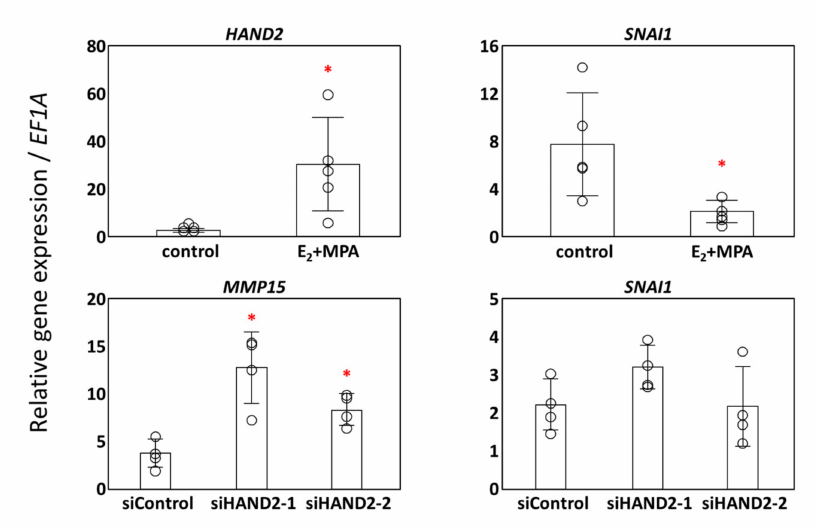
Figure 3. Effect of siRNA-mediated HAND2 silencing on the expression of MMP15 or SNAI1 in human endometrial stromal cells. Human endometrial stromal cells (ESCs) were treated with E 2 (10 − 8 mol/L) + MPA (10 − 7 mol/L) or without hormonal treatment (control) for 12 days. HAND2 and SNAI1 were analyzed by quantitative RT-PCR ( n = 5, upper panels). ESCs were transfected with human HAND2 siRNA (HAND2-1 and HAND2-2) or a non-silencing RNA on day 0 and then cultured for 5 days without hormonal treatment (lower panels). MMP15 and SNAI1 were quantified using quantitative RT-PCR and corrected for EF1A (lower panels). The bars show the mean of relative gene expression ± SD of independent experiments using cells derived from different patients ( n = 4). Each dot indicates the value for cells derived from different patients. An asterisk indicates statistically significant differences from the control group, * p <